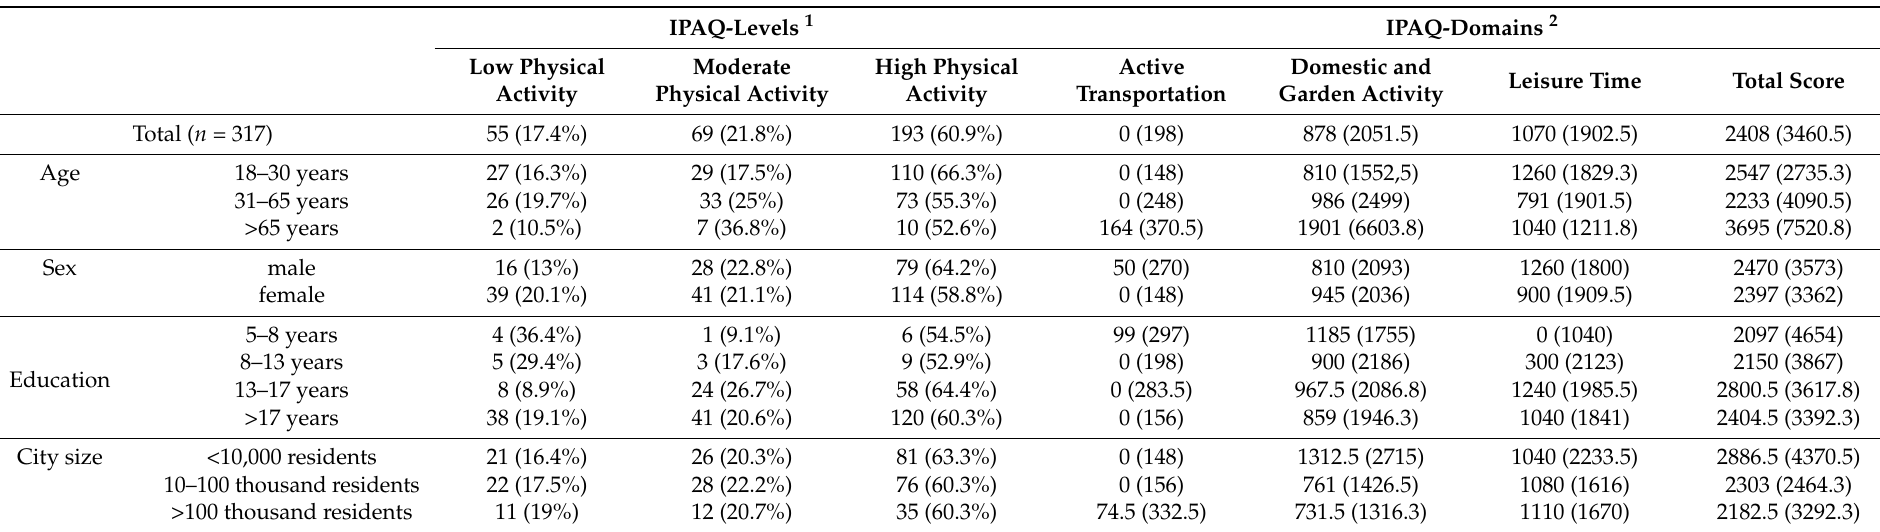
Table 2. International Physical Activity Questionnaire (IPAQ) results. The table shows the demographic characteristic of the sample according to the level of PA. METs-min/week for IPAQ domains are reported for the whole sample and according to demographic